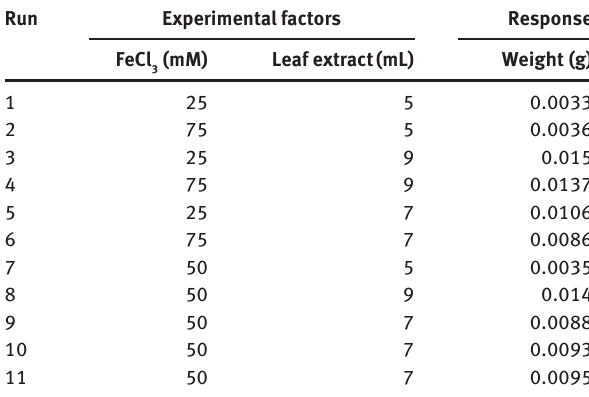
Table 3: Central composite face design matrix for the significant variables and observed response.